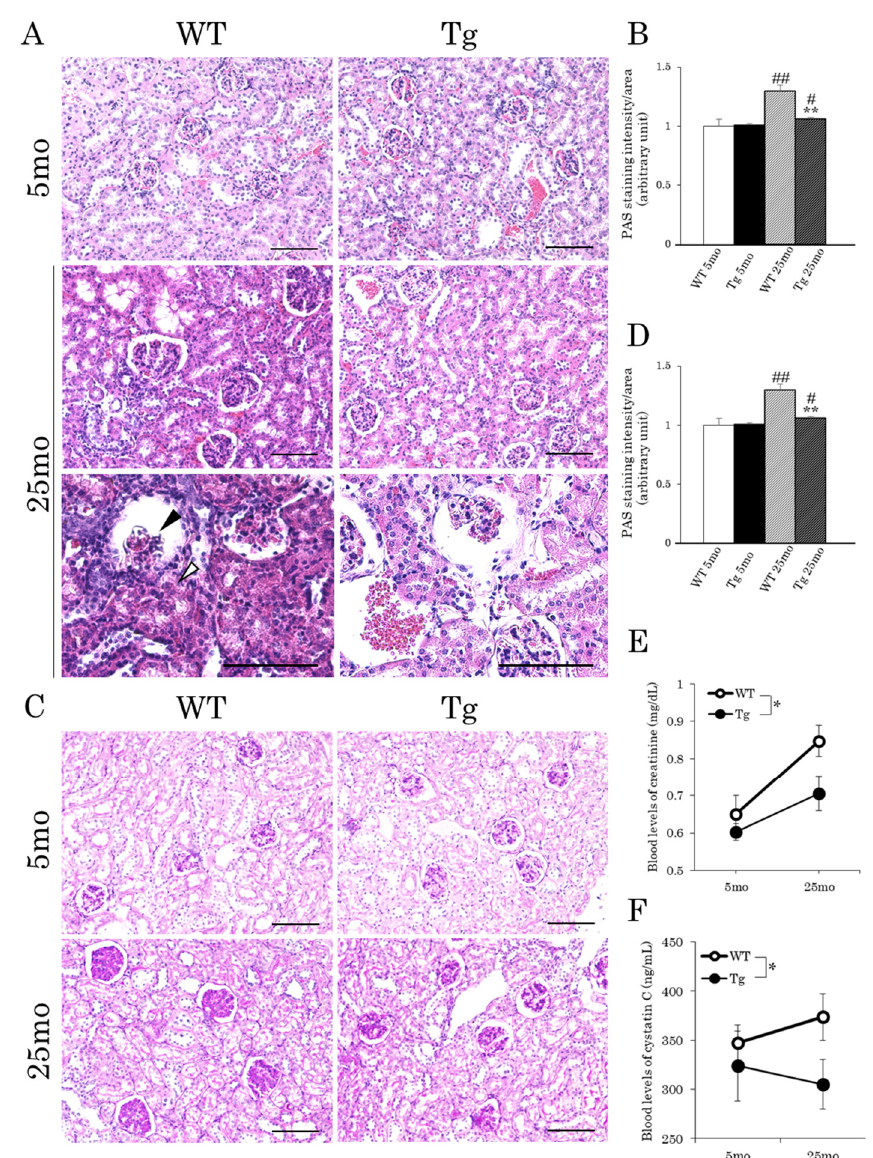
Figure 4. Age-related changes in kidney morphology and serum creatinine and cystatin C levels in aP2-CREG1-Tg mice. ( A ) H&E staining in kidney. The black arrow and white arrow indicate atrophied glomeruli and tubules, respectively. ( B ) Mean area of glomeruli ( n = 4–5). ( C ) Periodic acid–Schiff (PAS) staining in kidney. ( D ) PAS staining intensity of glomeruli ( n = 4–5). ( E ) Creatinine change in serum. ( F ) Cystatin C change in serum. ( A , C ) Scale bars, 100 μ m. Representative images are shown. Data are means ± SEM ( n = 4–5). * p < 0.05, ** p < 0.01 vs. WT at the same time point; # p < 0.05, ## p < 0.01 vs. 5 months for the same